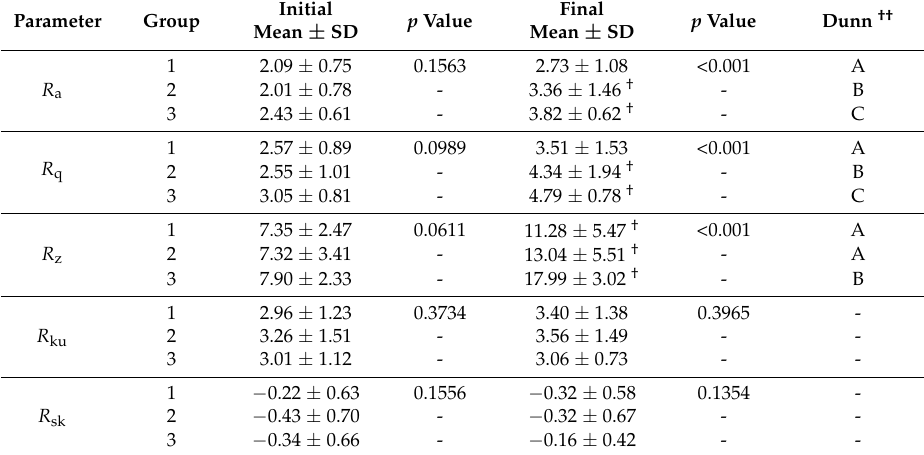
Table 1. Results of the Mean and Standard Deviation (SD) of the Surface Roughness within Groups ( X -axis), in µ